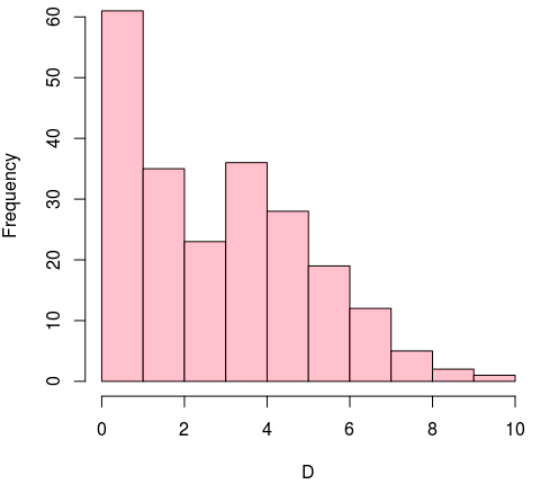
Figure 4. Distribution of differences ( D) between relative positions among aTSS conserved in H. salinarum NRC-1 and H. volcanii DS2. Positions are coding sequences (CDS) length-normalized thus D = 0 mean same position in both organisms.